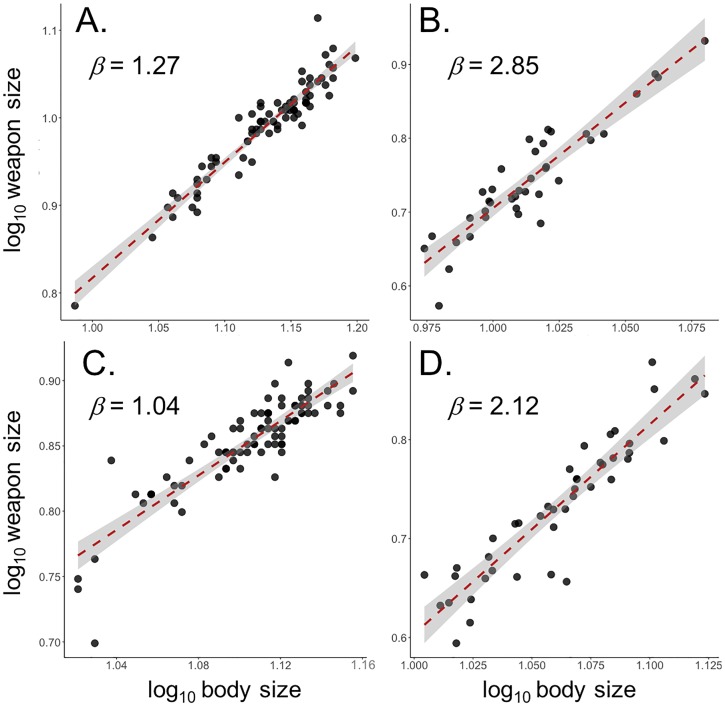
Relationship between weapon size and body size for A) male S. femorata, B) male N. femorata, C) female S. femorata, and D) female N. femorata.Red lines represent OLS regression. Shaded areas represent 95% confidence intervals around OLS regressions.